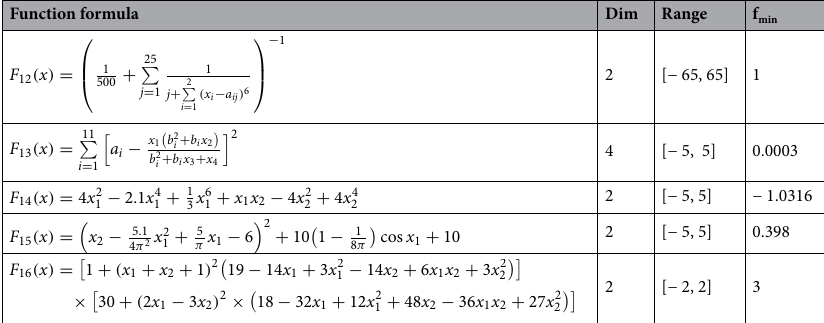
Table 4. Fixed-dimension multimodal functions.